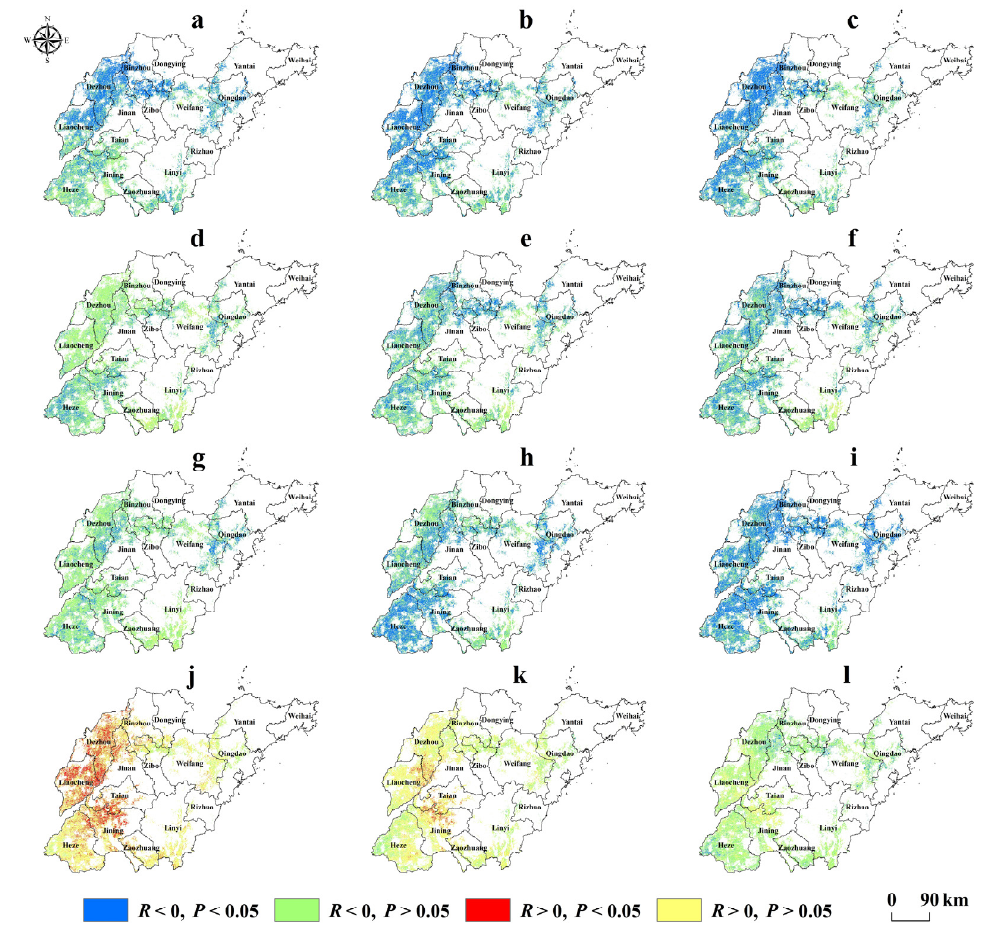
Figure 10. ( a – l ) Same as Figure 9 but for minimum